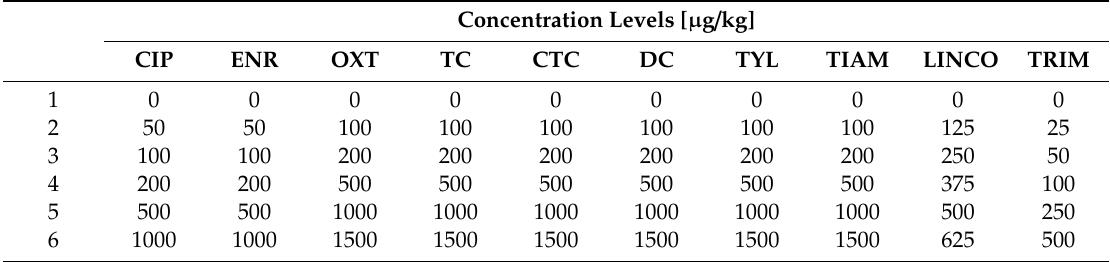
Table 5. Concentration levels of matrix match calibration curves for all analyzed compounds.